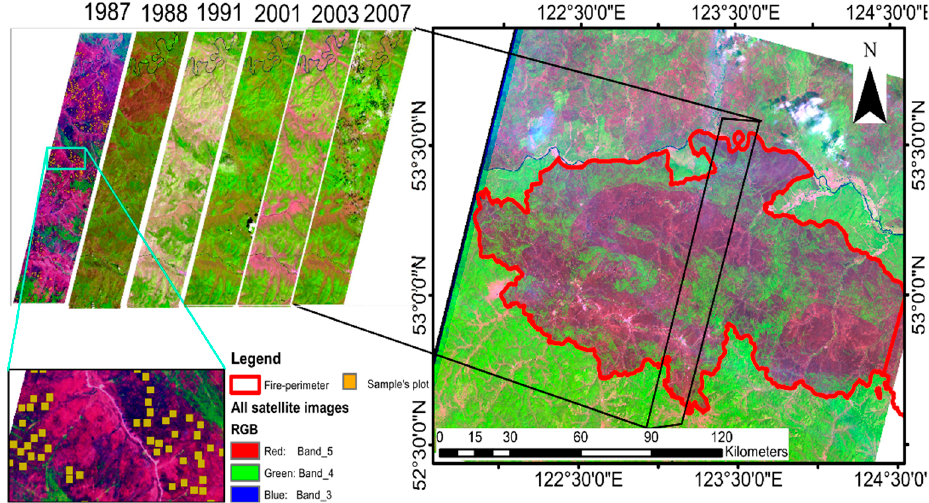
Figure 1. The perimeter of the fire area obtained from Chen et al. [3] and the sample plots distribution on the high-severity area.